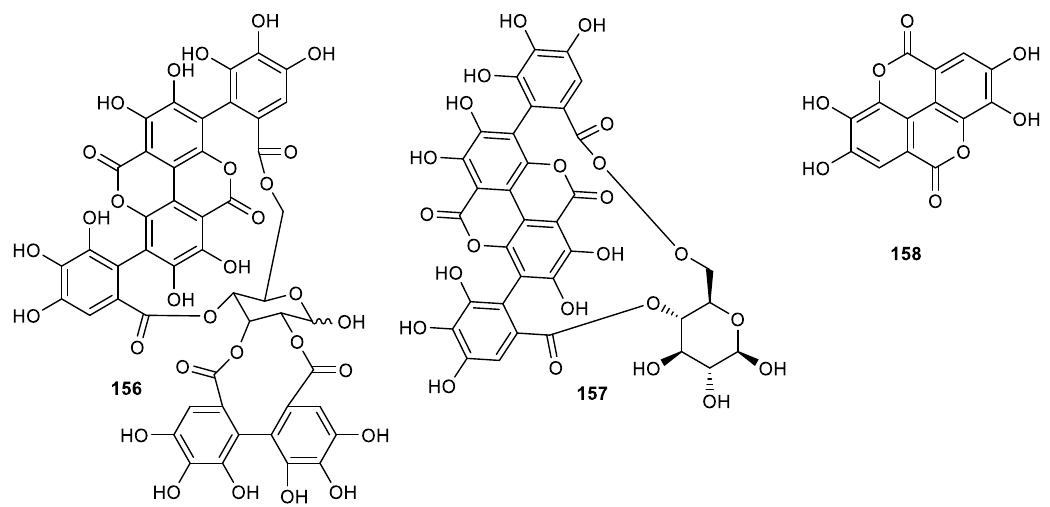
Figure 18. Structures of tannins 156 – 158 .